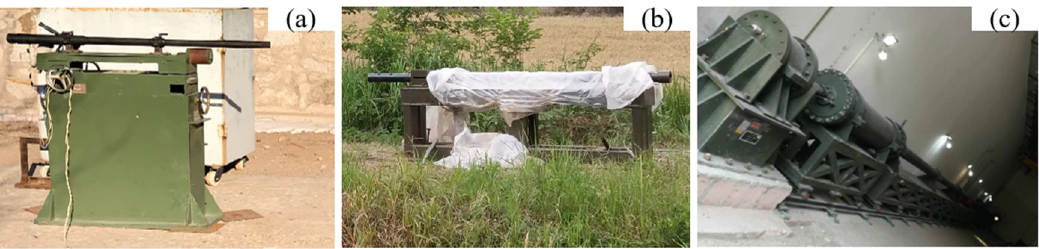
Figure 3. Three fragment acceleration devices. ( a ) A ballistic gun; ( b ) a 37 mm gun; and ( c ) a two-stage light-gas gun.